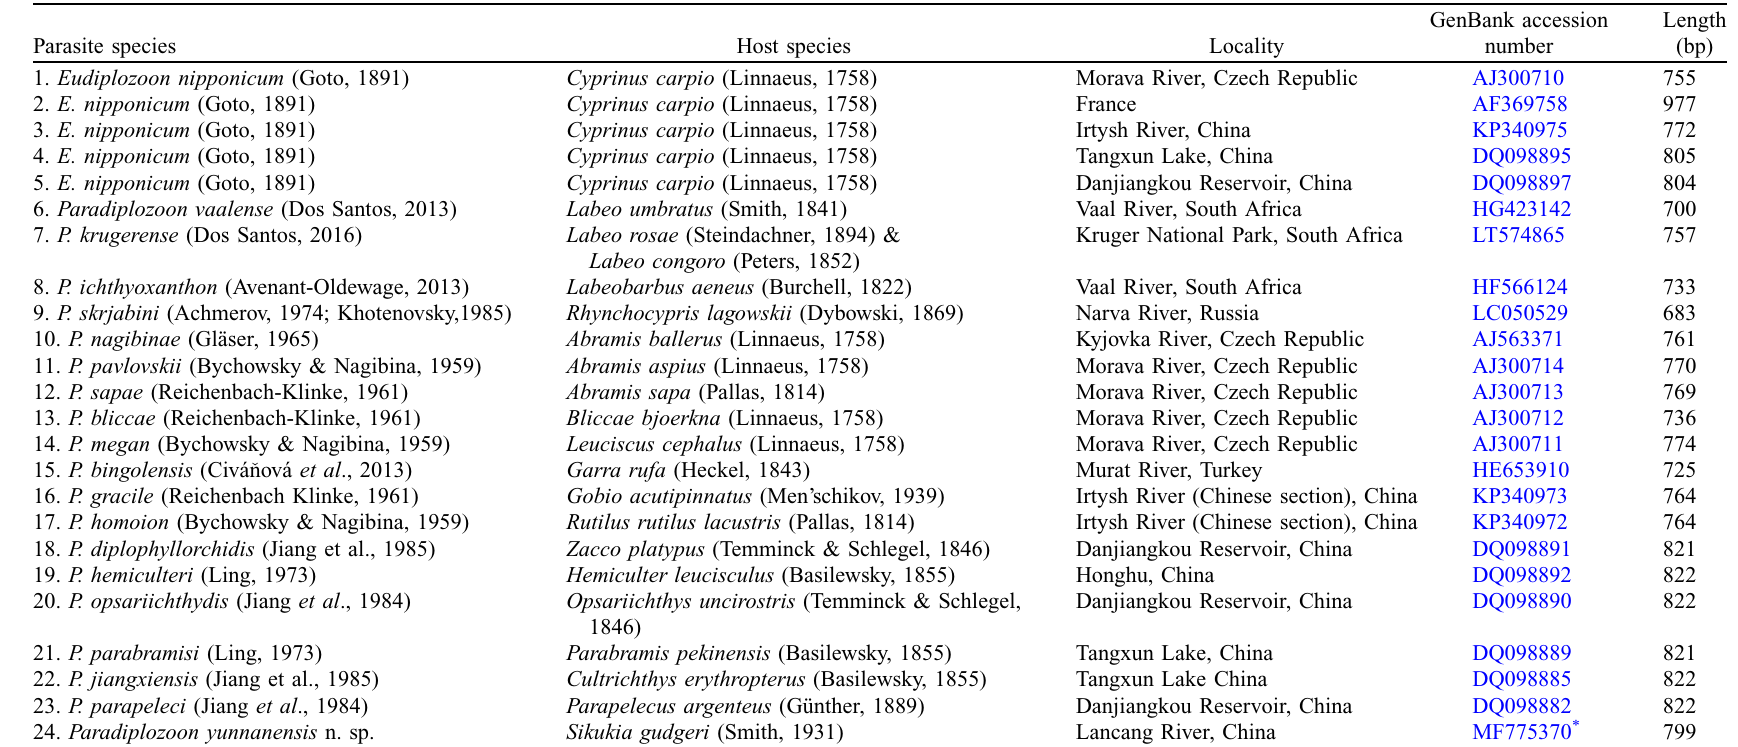
Table 1. List of diplozoid species used for genetic comparison and phylogenetic research with Paradiplozoon yunnanensis n. sp., including their host species, locality, GenBank accession number and sequence